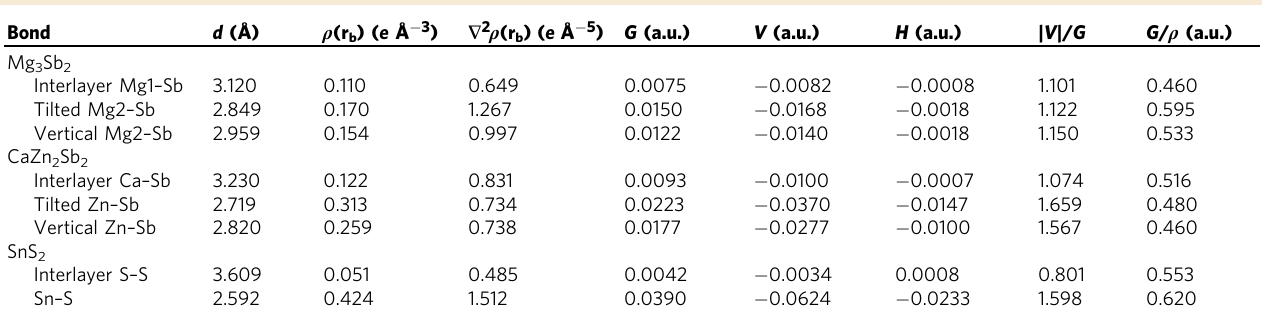
Table 1 Topological properties of the bond critical points (r b